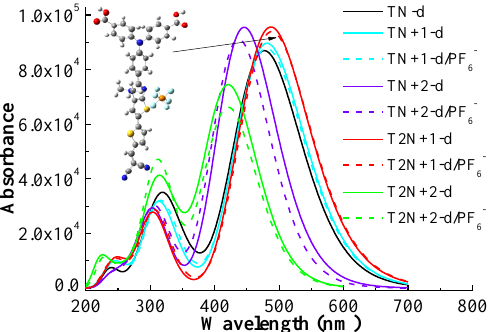
Figure 5. The comparison of the simulated UV-vis absorption spectra between RN + / PF 6 − and the RN + .